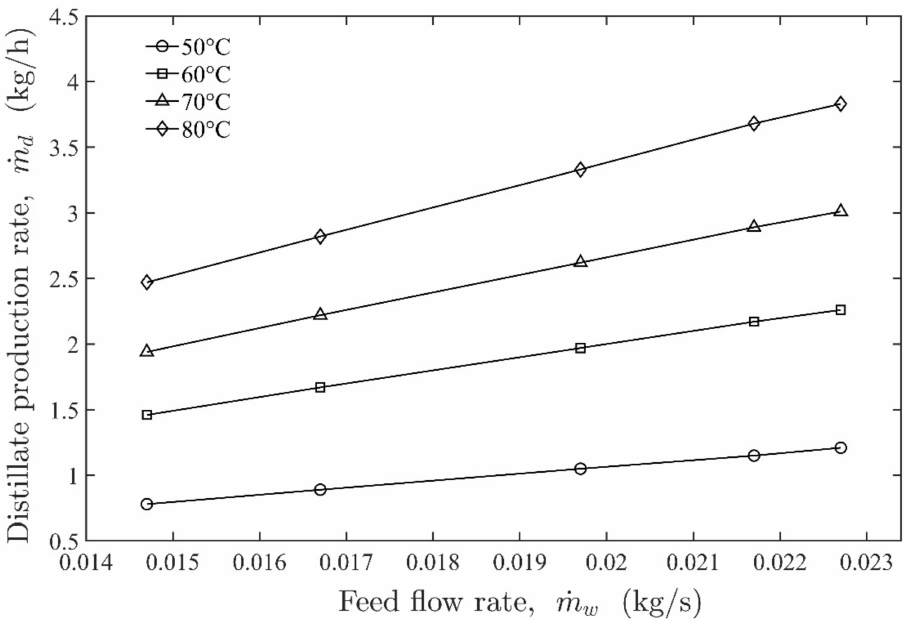
Figure 9. Distilled water flow rates vs. CDI brine flow rate at dehumidifier inlet for different humidifier inlet water temperatures in HDH with MR = 3 for all five cases of feedwater flow rate.